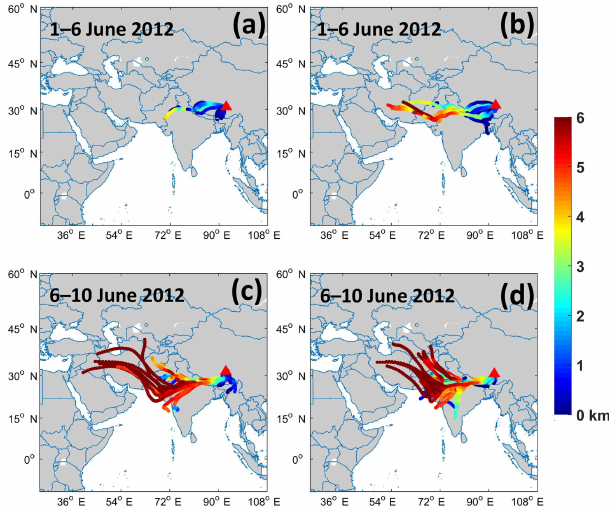
Figure 12. Backward air trajectories arriving at NMC with end- point heights of 500m (a, c) and 1500m (b, d) for the periods 1– 6 June 2012 (a, b) and 6–10 June 2012 (c, d) . The color scale shows trajectory heights in km above ground